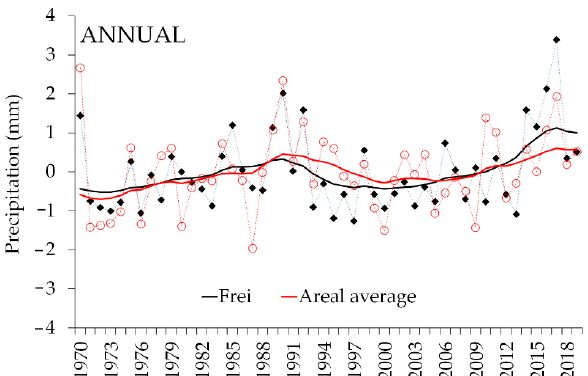
Figure 4. Annual standardized anomalies of precipitation registered at Frei station and the areal average given by Frei, Prat, and O’Higgins station for the 1970–2019 period.